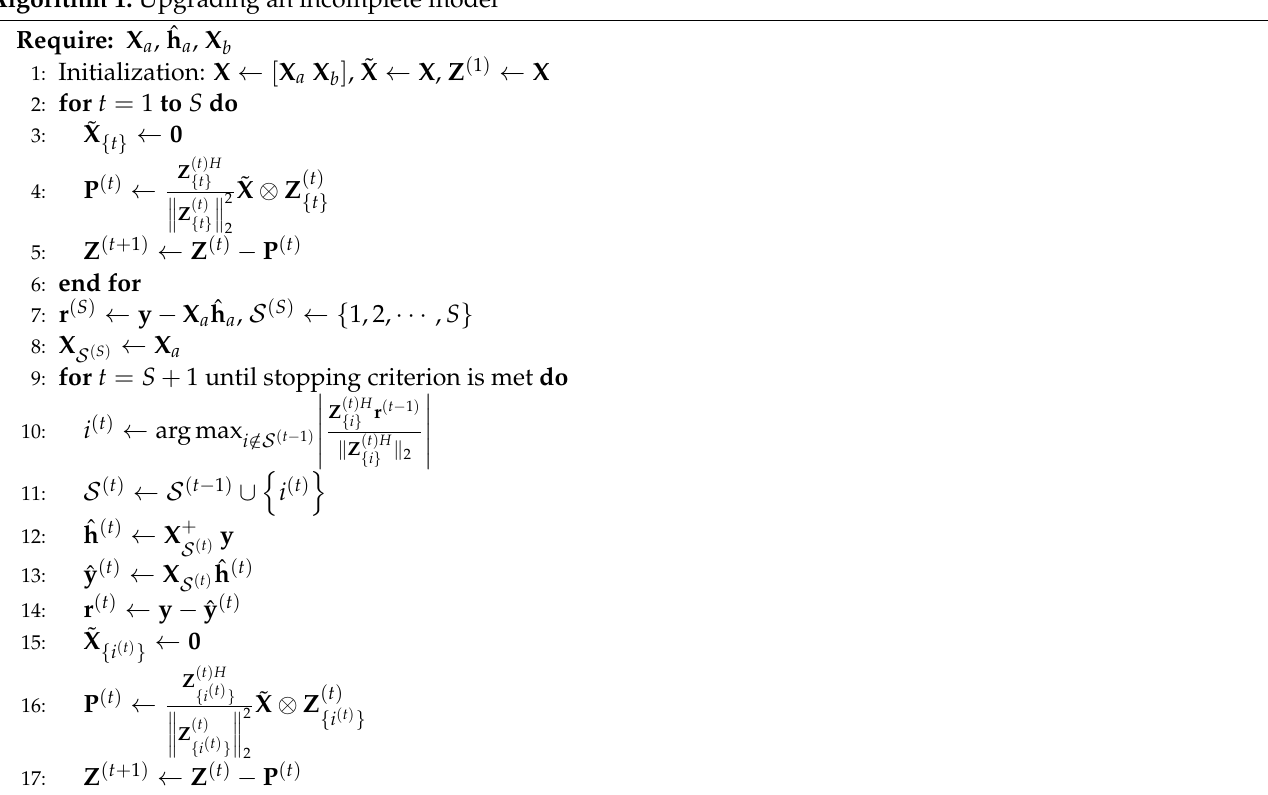
Algorithm 1: Upgrading an incomplete